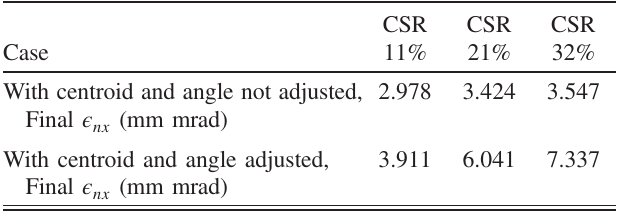
TABLE VI. Final normalized emittance from the 5 m plasma source. CSR 11%, 21%, and 32% indicate that the CSR-induced emittance growths before entering the plasma source are 11%, 21%, and 32% from the initial emittance of 1.936 mm mrad.